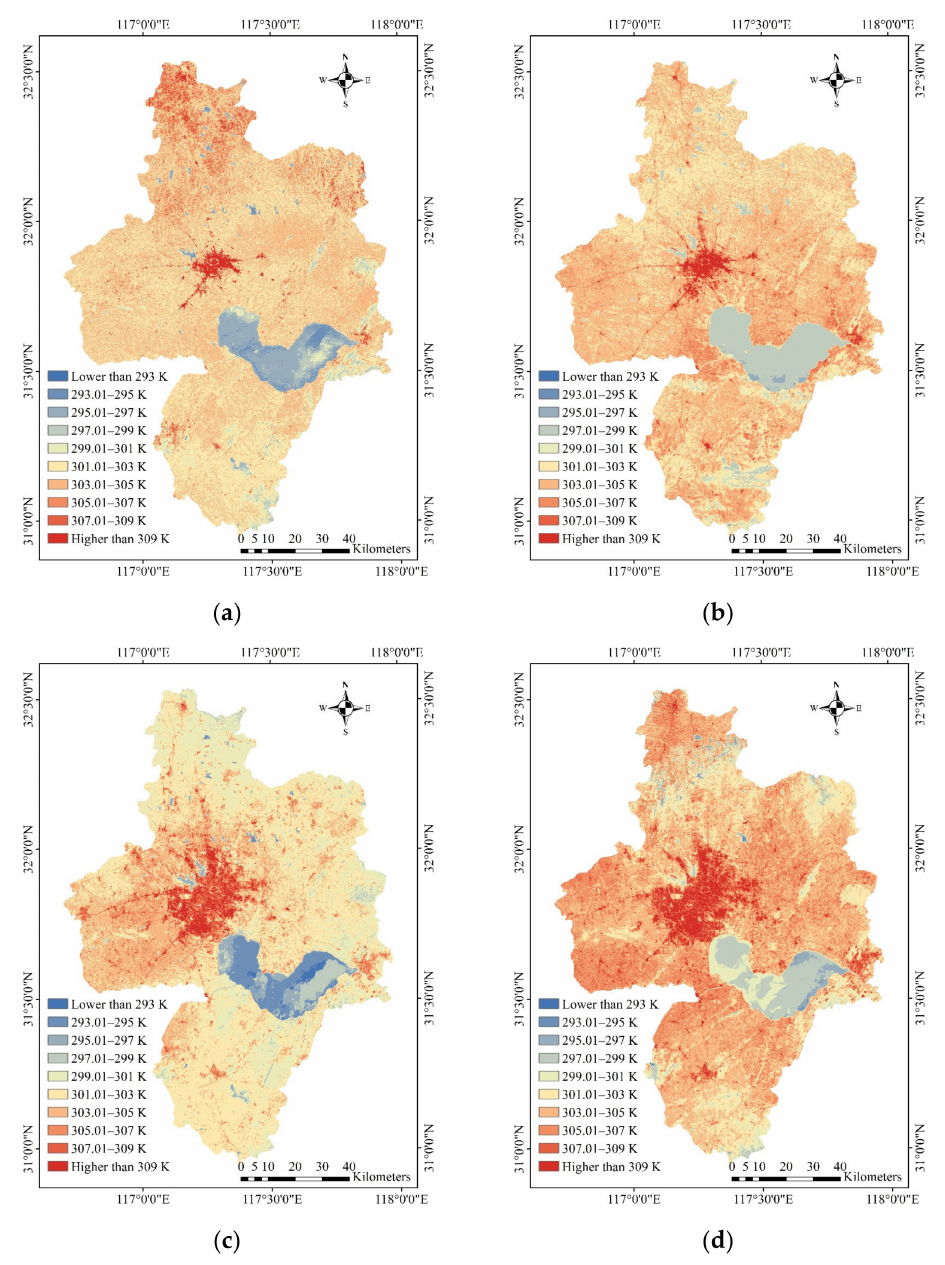
Figure 13. Spatial distribution of LST: ( a ) 21 May 2001; ( b ) 27 May 2006; ( c ) 1 May 2014;